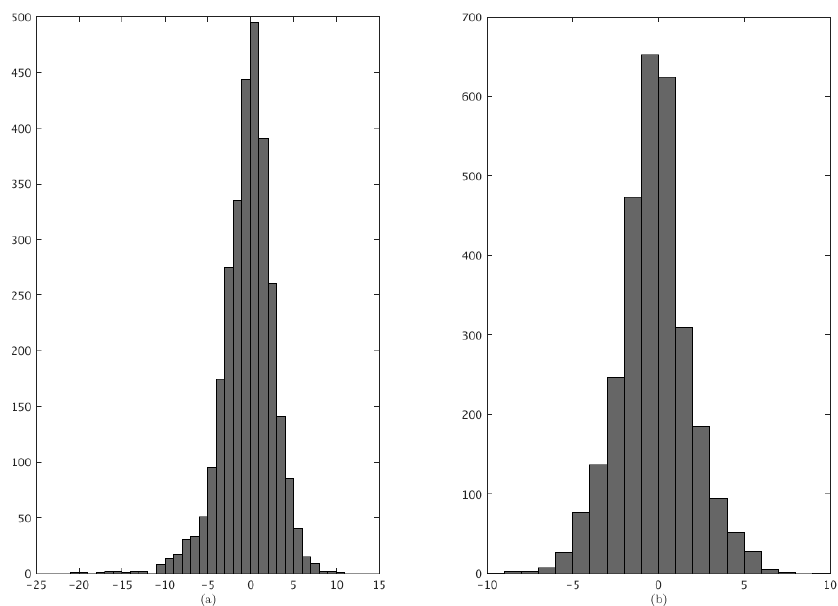
Figure 9. Histograms of the biases (°C) between HIRS retrievals and radiosonde observations for temperature ( a ) and humidity ( b ) at 850 hPa.